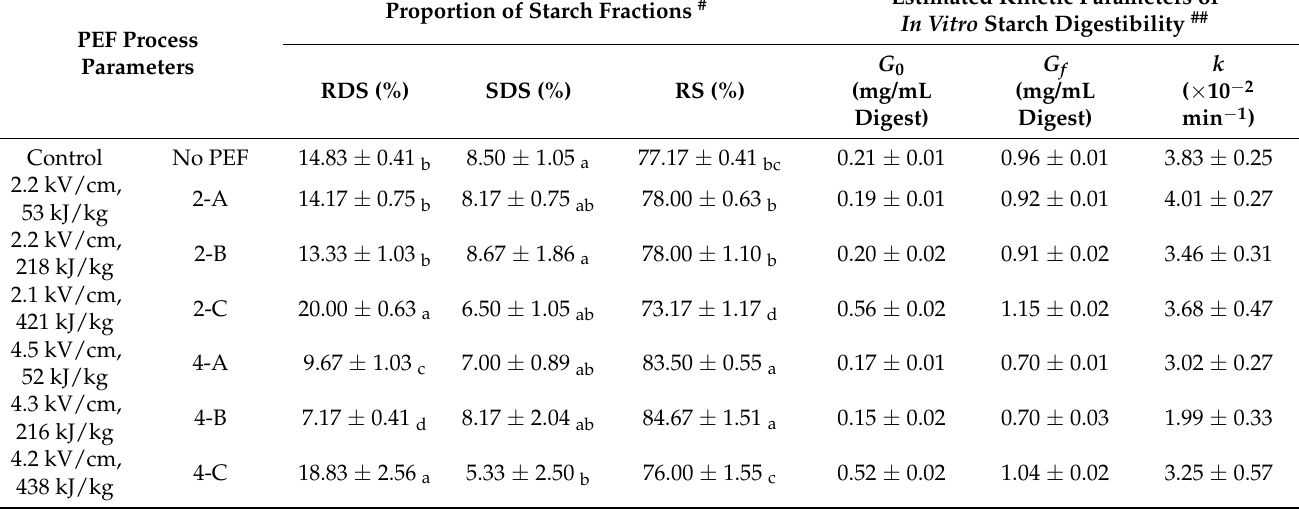
Table 1. Calculated proportions of readily digestible starch (RDS), slowly digestible starch (SDS), and resistant starch (RS) and the estimated kinetic parameters of in vitro starch digestibility for PEF-treated oat